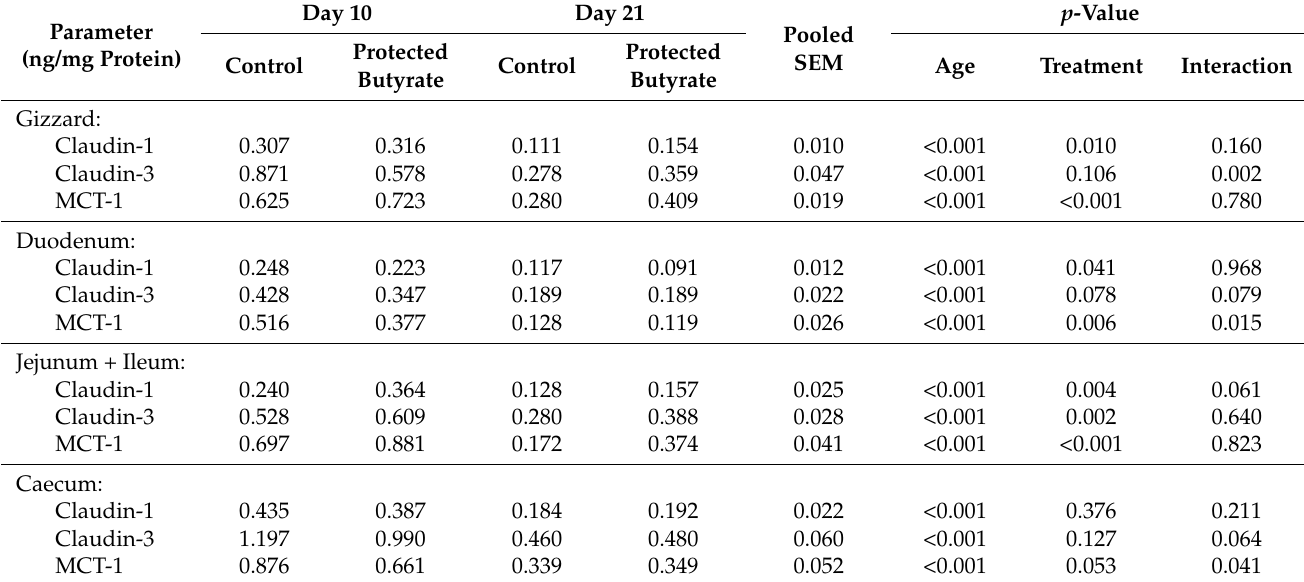
Table 4. Effect of protected butyrate supplementation on tight junction proteins (claudin-1